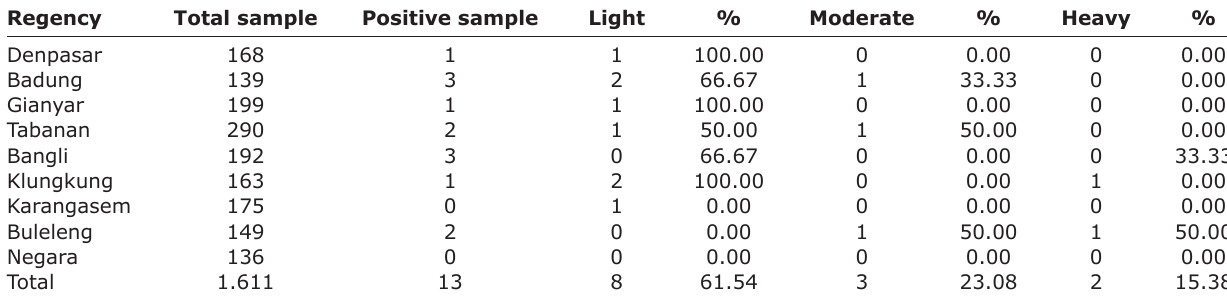
Table-5: The intensity of Trichuris spp. infection in free-roam dogs and its distribution in Bali Province. Regency